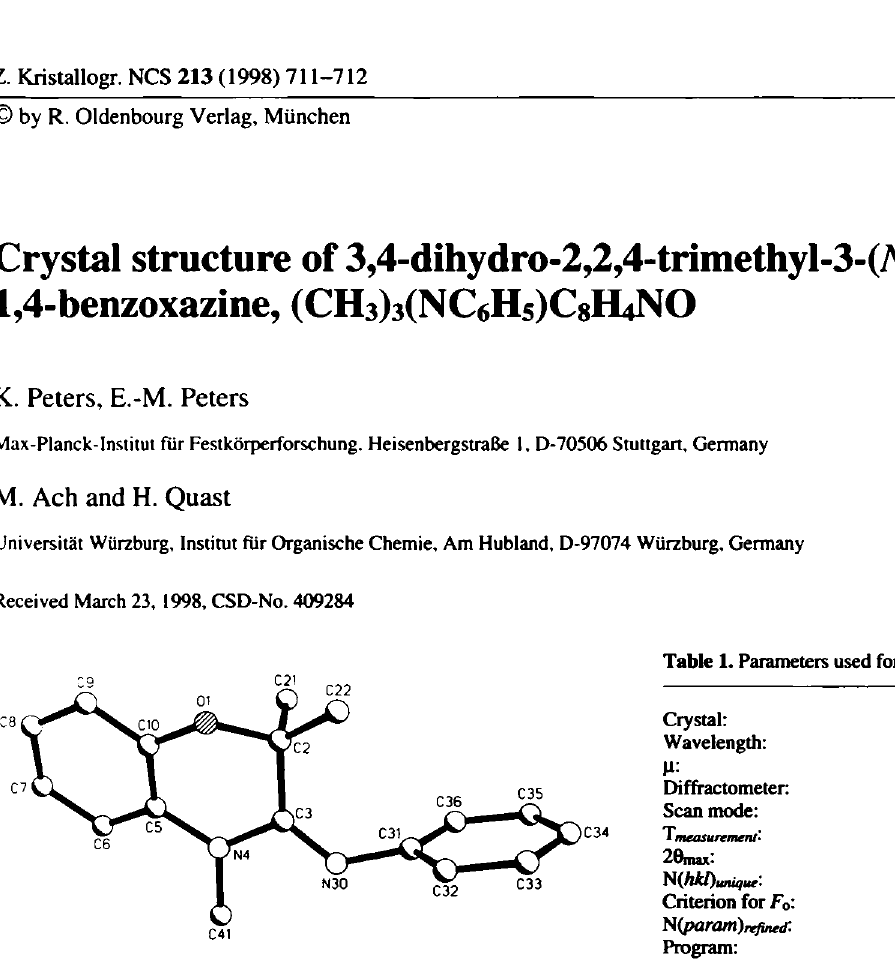
Table 2. Final atomic coordinates and displacement parameters (in